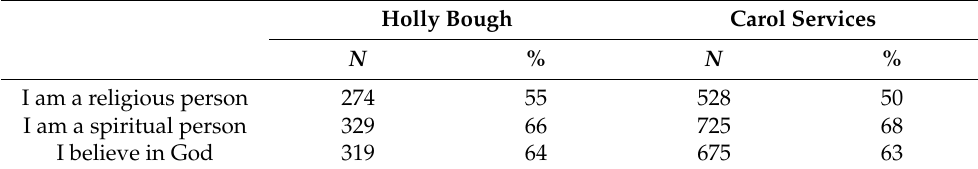
Table 11. Self-assessed religiosity.